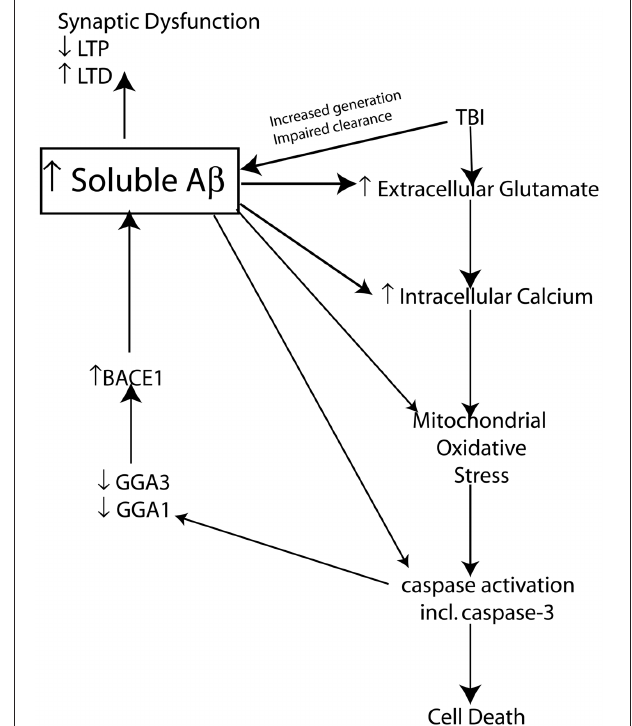
FIGURE 3 | Schematic representation of the proposed mechanism by which TBI induced increases in A β create a vicious neurotoxic cascade leading to chronic neurodegeneration. Soluble A β levels are increased both clinically and experimentally following TBI and are known to impair synaptic plasticity and hence cognitive function by inhibiting LTP and enhancing LTD mechanisms of memory formation. The increased A β observed following TBI presumably occurs through a combination of increased generation and impaired clearance mechanisms. BACE1 levels are elevated following experimental TBI and directly contribute to the observed increases in A β . Caspase-3 mediated cleavage of BACE1 interacting adaptor proteins GGA1 and GGA3 has been demonstrated to modulate BACE1 levels and A β production following experimental TBI. The increased A β levels observed due to mechanisms including caspase mediated depletion of GGA1 and GGA3 could theoretically create a vicious feed forward mechanism leading to further propagation of A β . In vitro evidence suggests that A β is capable of initiating and mediating many of the cellular injury mechanisms that lead to programmed cell death following